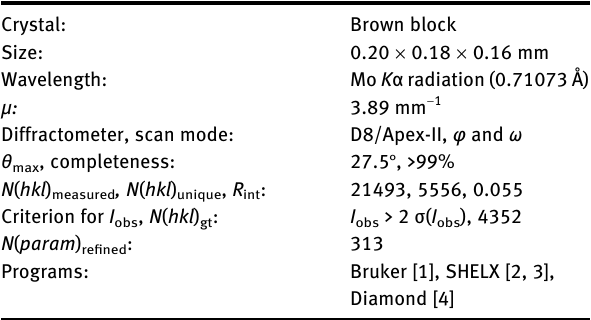
Table  : Data collection and